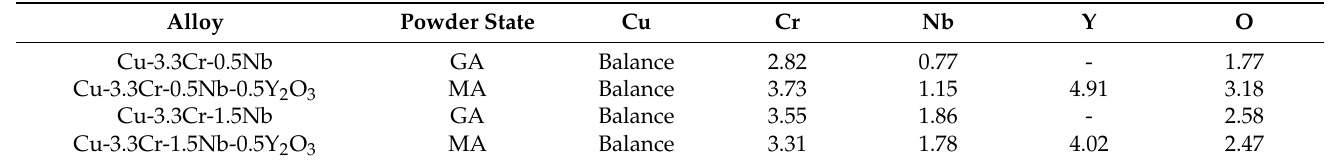
Figure 3. SEM images (SE mode) of mechanically alloyed powder particles with superimposed SEM image with higher magnification: ( a ) Cu-3.3Cr-0.5Nb alloy. ( b ) Cu-3.3Cr-1.5Nb alloy.